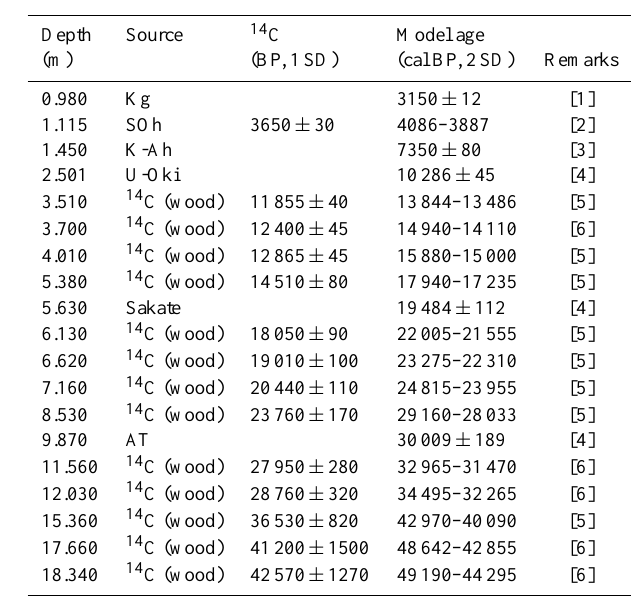
Table 1. Age controls of core